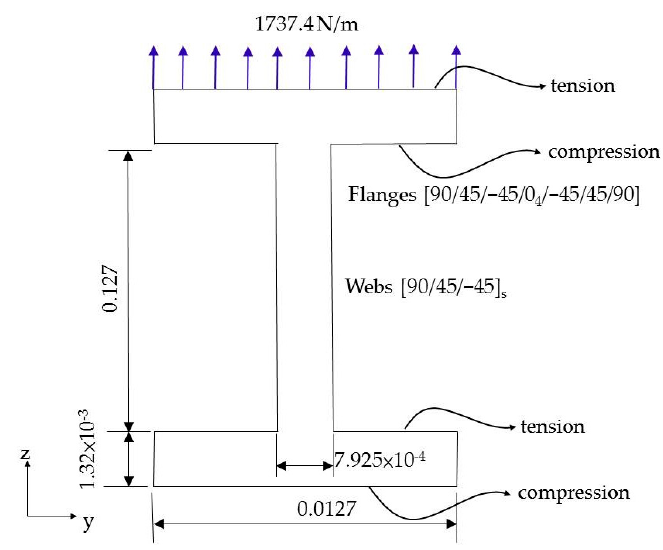
Figure 6. Structure and loading diagram of laminated composite I-beam.